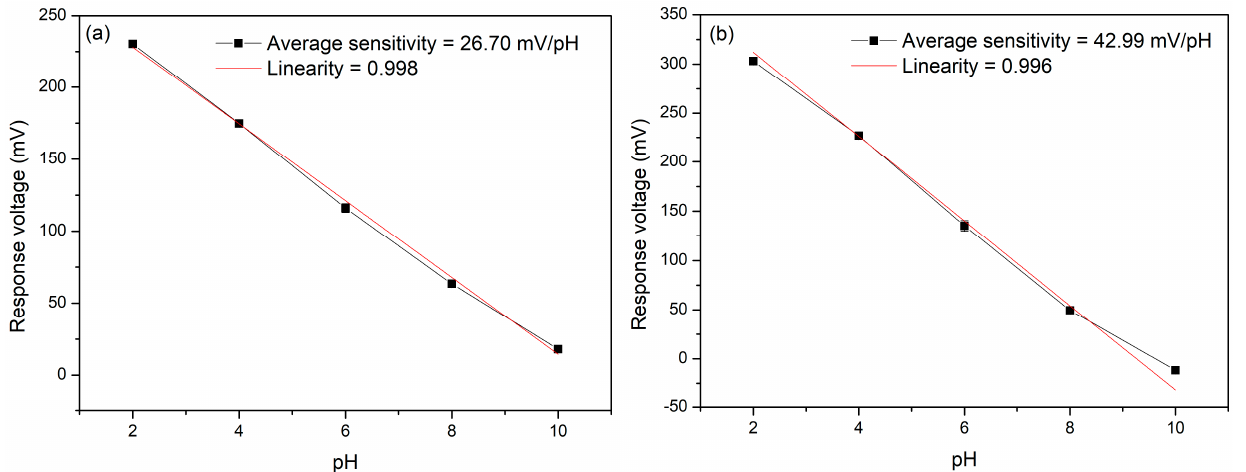
Figure 5. The average sensitivity and linearity of the pH sensors based on ( a ) bare ZnO film and ( b ) bare AZO film.